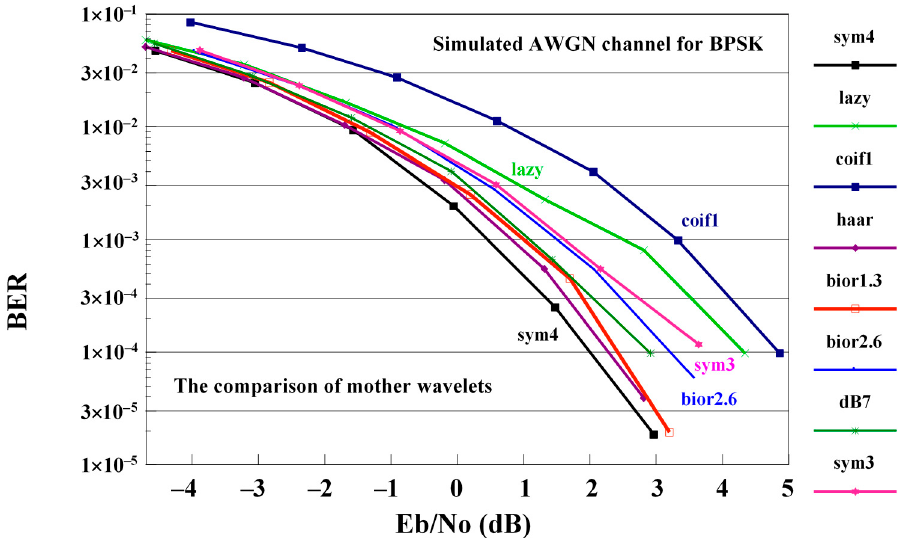
Figure 5. The comparison of performance of the proposed WHT-LWT-GFDM obtained using different mother wavelets on the AWGN channel.